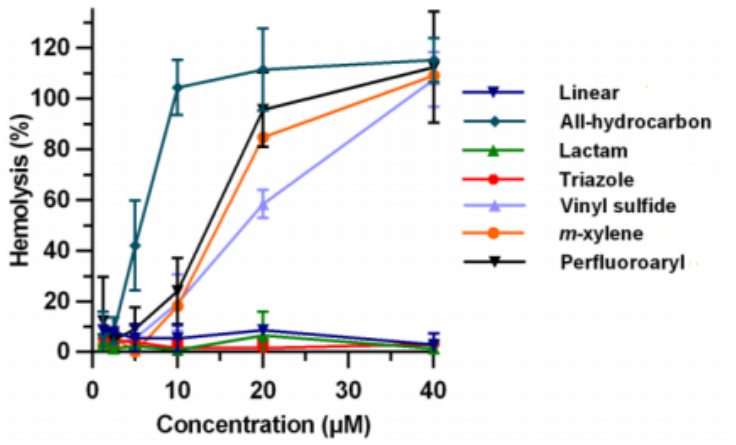
Figure 10. Haemolytic activity of stapled α -helical peptides with different types crosslinks